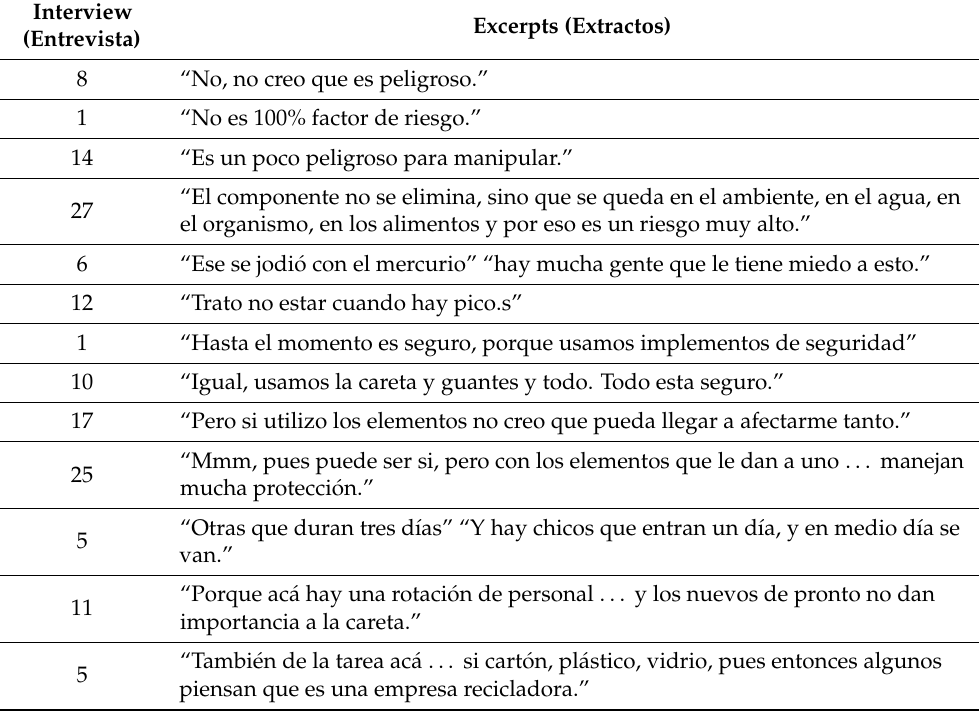
Table 2. Interview excerpts from text transcribed in original